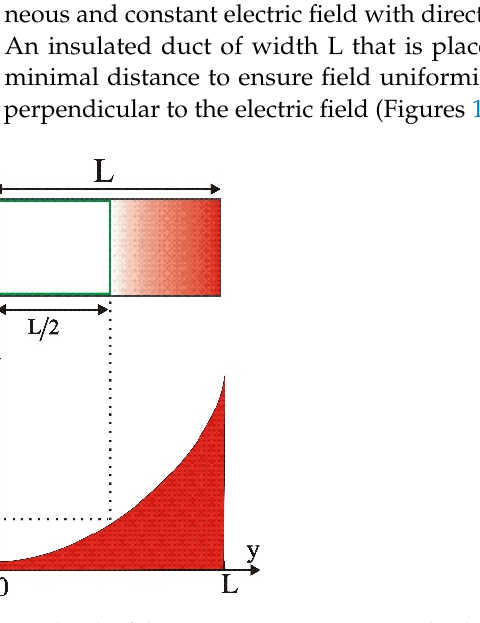
Figure 2. Sketch of the ion concentration across the duct of width